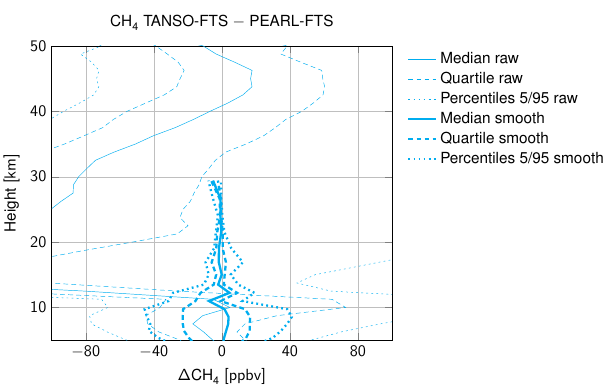
Figure 13. As in Fig. 9, but for ACE-FTS and TANSO-FTS. Note that collocations are limited to the quadrangle 60–90 ◦ N, 120– 40 ◦ W.